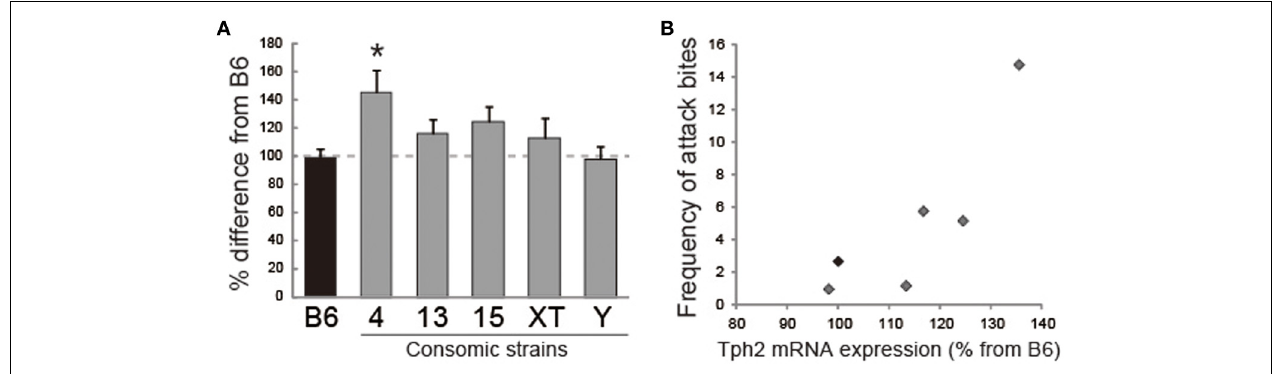
∗ Significant difference compared with B6 ( p < 0 . 05). (B) Positive genetic correlation between Tph2 expression and the frequency of attack